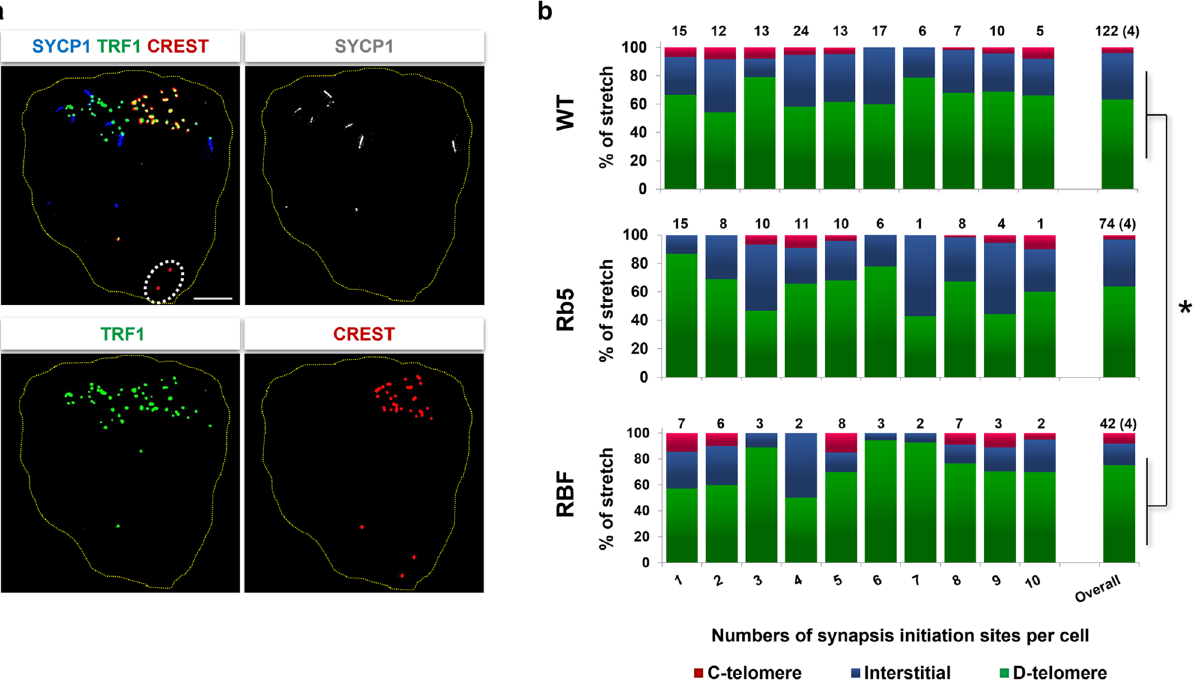
Figure 3. Initiation of chromosome synapsis in Rb5, RBF, and WT BALB/c oocytes at the early zygotene stage. ( a ) Rb5 oocyte with six short SYCP1 stretches (1–4 µm). C-telomeres, D-telomeres and interstitial regions are distinguished with IF-staining with anti-TRF1 and CREST antibodies. The merged image is followed by SYCP1, TRF1, and CREST staining alone. The circle with broken line indicates RbT-centromeres. ( b ) Percentages of short SYCP1 stretches at three chromosomal regions from the oocytes of three genotypes. The number of short stretches per oocyte is given on the X axis. The total number of examined oocytes is given on the top of each column. The results are combined as total at the right end. Four females were examined in each strain. *Significance in RBF oocytes compared to WT oocytes at P < 0.05 by χ 2